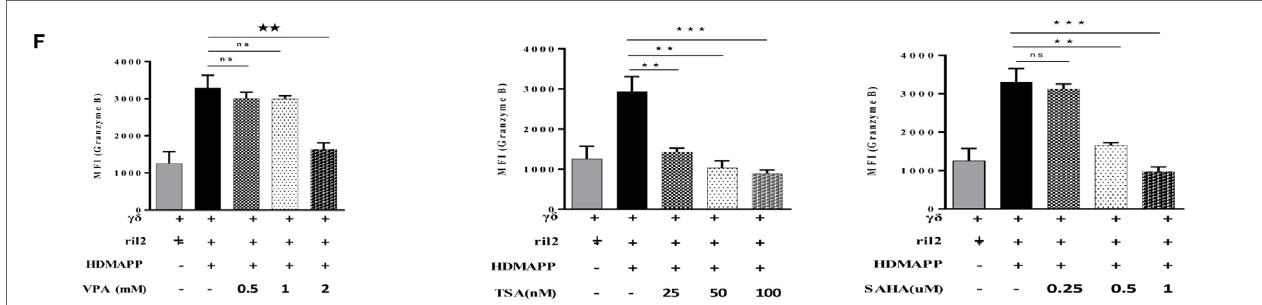
FigUre 5 | Histone deacetylases (HDAC) inhibitor treatment abrogates the antitumor potential of γδ T cells. Expression of perforin and granzyme was studied at mRNA and protein levels using quantitative real-time PCR and flow cytometry, respectively. The gene expression of (a) perforin and (D) granzyme B by HDMAPP- stimulated γδ T cells with or without HDAC inhibitor treatment was quantified by quantitative real-time PCR. The results shown are cumulative means of relative gene expression, normalized to 18S r-RNA, and representative of three independent experiments. (B) γδ T cells activated by HDMAPP with or without sodium valproate, Trichostatin-A, and suberoylanilidehydroxamic acid at different concentrations were stained after 72 h with corresponding flurophore tagged antibody and expression of perforin was analyzed by flow cytometry. The values on right side of histograms indicate median fluorescence intensity (MFI) of perforin, while the values inside the histogram represent the percent positive γδ T for perforin. (c) Bar graphs represent cumulative MFI values where * p < 0.05, ** p < 0.005, *** p < 0.0005, compared with γδ T cells activated with HDMAPP. (e) Expression of granzyme B by unstimulated γδ T cells and HDMAPP activated γδ T cells with or without HDAC inhibitor treatment was assessed by flow cytometric analysis. The values on right side of histograms indicate MFI of granzyme B, while the values inside the histogram represent the percent positive γδ T for granzyme B. The histograms are representative of three independent experiments. (F) The graphs represent MFI values of granzyme B where * p < 0.05, ** p < 0.005, *** p <